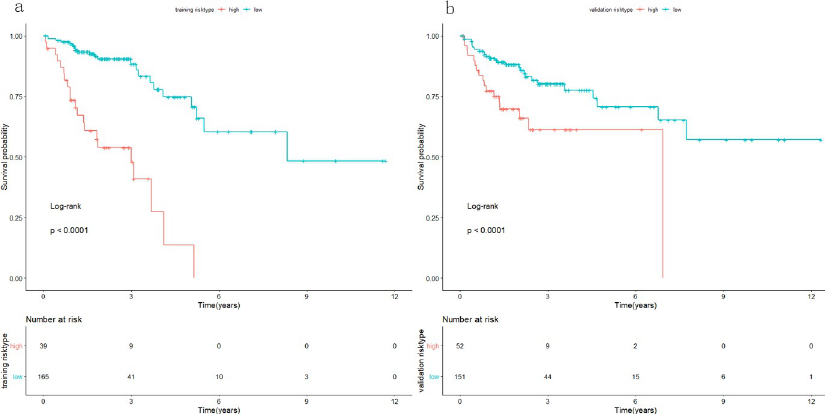
Fig 2. Survival analysis in the training and validation cohorts. In the training (a) and validation (b) cohorts, the patients were split into groups of high and low risk. Survival analysis was conducted by Kaplan-Meier analysis and log- rank